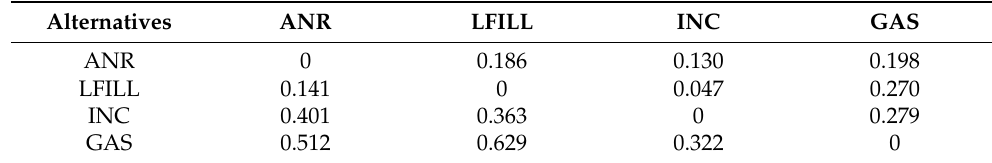
Table 9. Determining the leaving and entering flow.